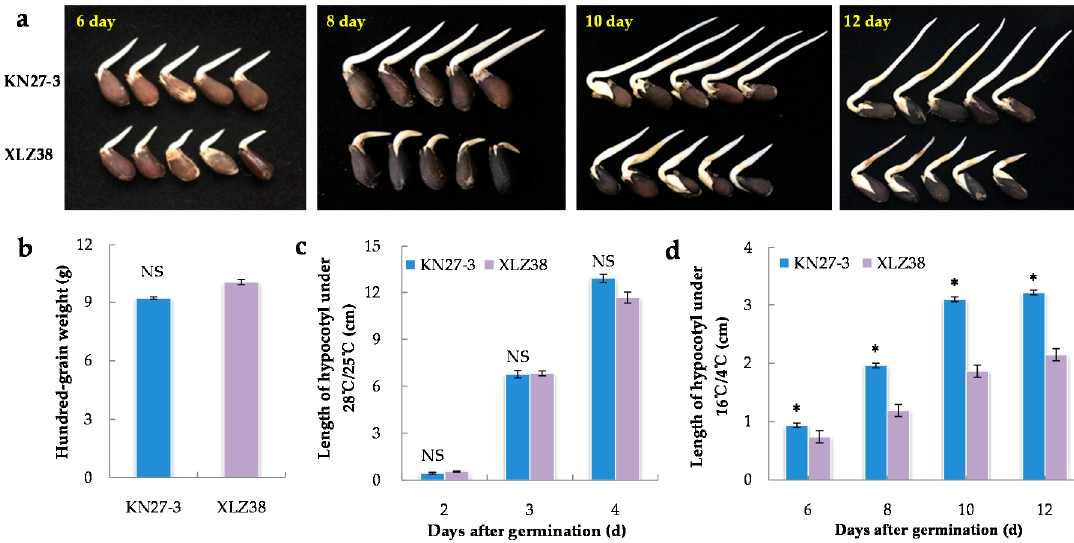
Figure 1. Morphological characteristics of KN27-3 and XLZ38 during germination under normal and chilling conditions. ( a ) Phenotypic differences between KN27-3 and XLZ38 on day 6, 8, 10, and 12 under 16 °C /4 °C; ( b ) hundred-grain weight of two varieties; length of hypocotyl after germination under 28 °C /25 °C ( c ) and 16 °C /4 °C ( d ). Bars marked with stars “*” are the samples showing difference ( p < 0.05) according to Duncan’s multiple range test using SPSS software. “NS” represents no difference.